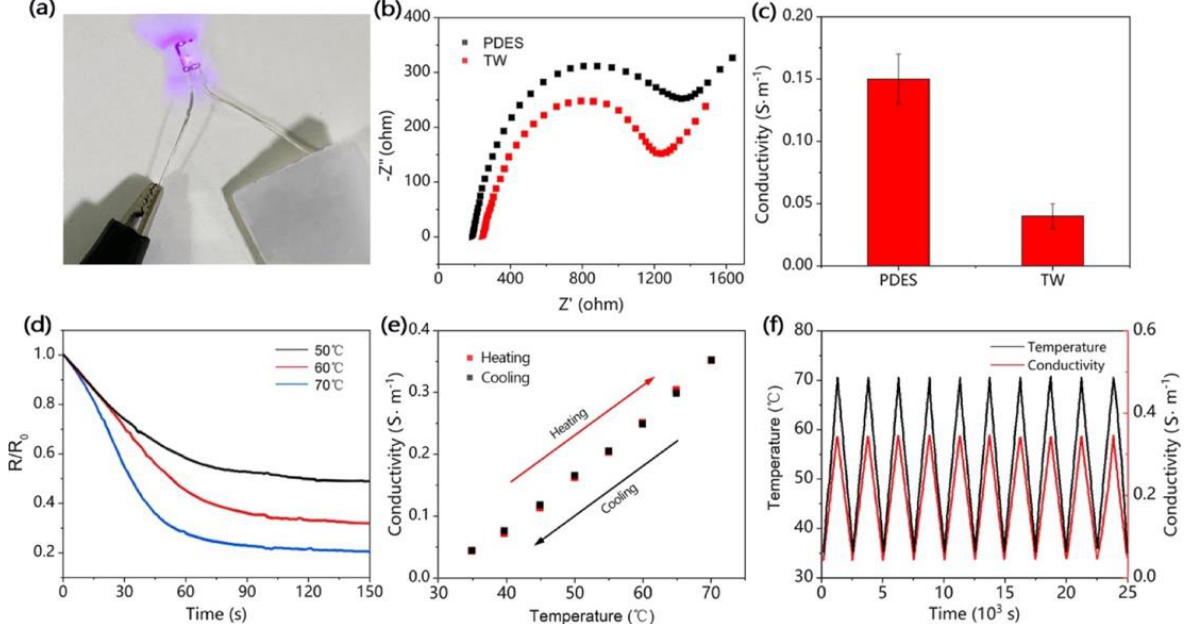
Figure 23. Electrical properties and temperature sensing performance of transparent wood (TW). ( a ) Digital image to demonstrate that the TW can illuminate an LED bulb. ( b ) Electrochemical im- pedance spectroscopy (EIS) plots of the deep eutectic solvent polymer (PDES) and TW. ( c ) Plots of